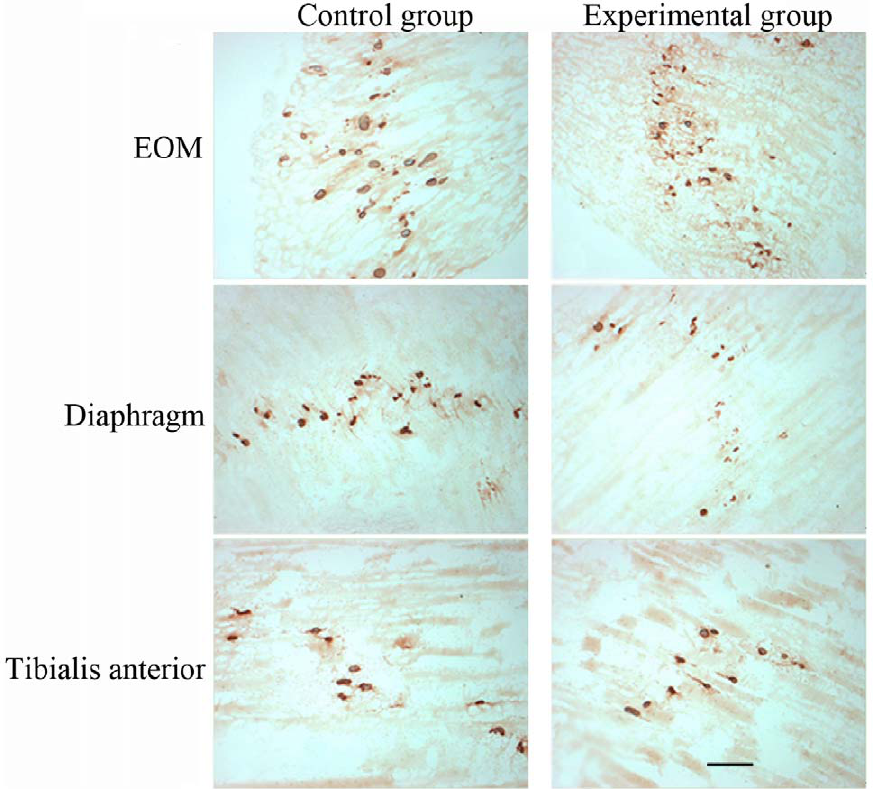
Figure 2. Acetylcholinesterase-positive endplates of three muscles in the two groups assessed by acetylcholinesterase (AChE) staining. Scale bar=50 m